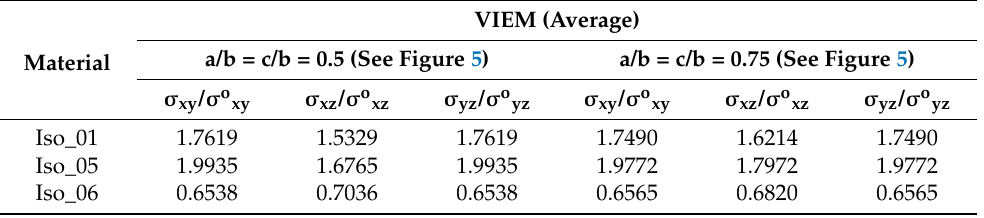
Table 20. Normalized shear stress components ( σ xy / σ o xy , σ xz / σ o xz and σ yz / σ o yz ) within